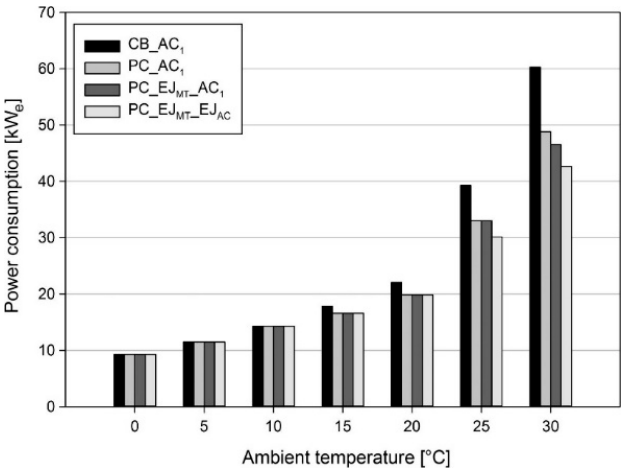
Figure 24. Electric power input of a conventional booster system (CB_AC), booster system with parallel compression (PC_AC), multi-ejector enhanced parallel compression system with (PC_EJ MT _EJ AC ) and without (PC_EJ MT _AC) AC multi-ejector module in a typical Norwegian food retail store ( p MT = 28 bar, p LT = 15 bar, p lift,AC = 5 bar, Q MT = 60 kW at t outdoor = 30 ◦ C, Q LT = 10 kW, Q AC = 45 kW at t outdoor = 30 ◦ C) [62].